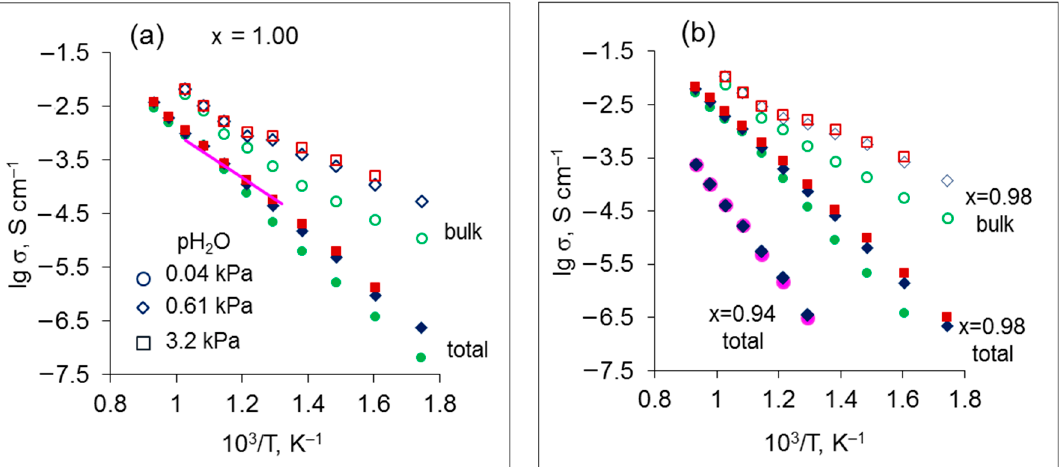
Figure 5. Arrhenius plots of the total and bulk conductivities of Sr x Zr 0.95 Yb 0.05 O 3– δ in air with different pH 2 O values: ( a ) x = 1.00, ( b ) x = 0.94 and 0.98. Solid and open symbols denote total and bulk conductivity, respectively; circles, diamonds and squares correspond to pH 2 O = 0.04 kPa, 0.61 kPa and 3.2 kPa, respectively. A solid line represents the total conductivity of SrZr 0.95 Yb 0.05 O 3– δ reported in [22].